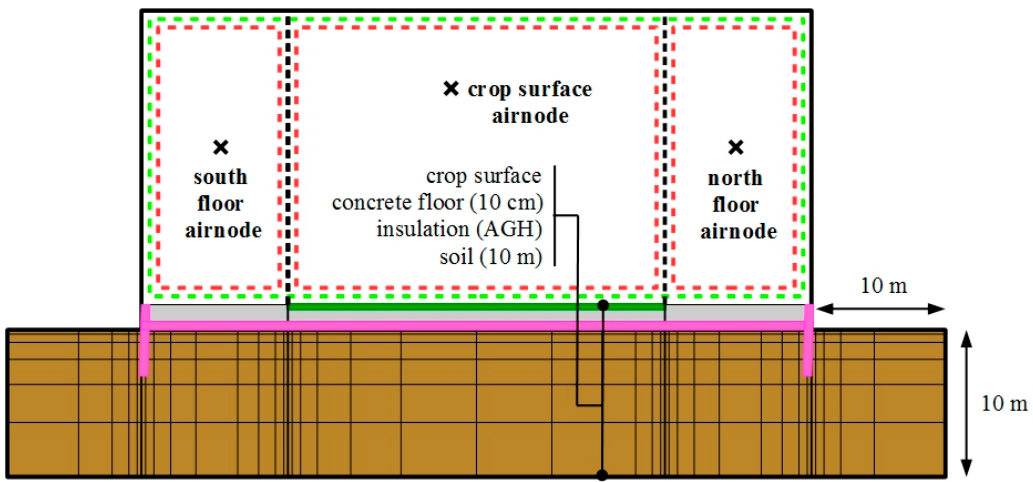
Figure 3. Greenhouse model with three airnodes and discretized ground zones.